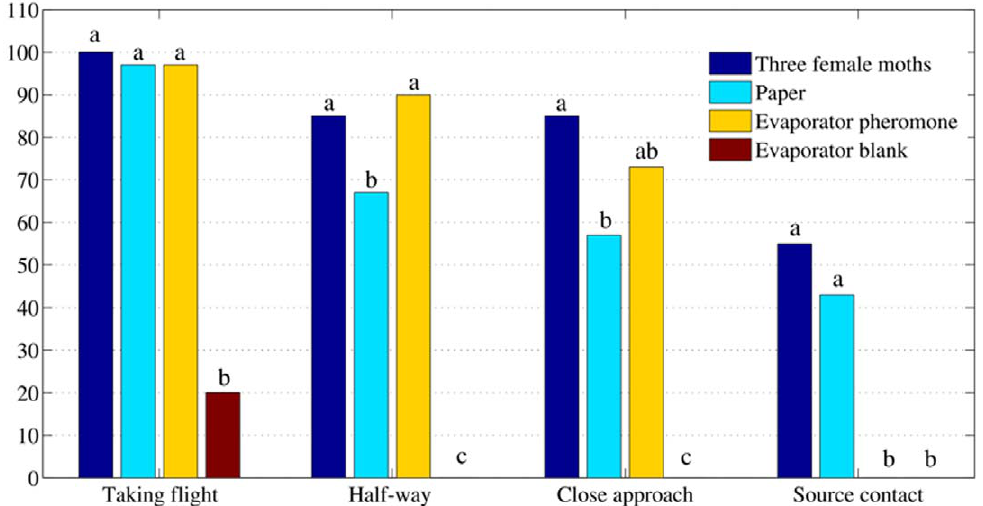
Figure 4. Behavioral responses of S.littoralis males (N=20 for each assay) to a 10 ng/ m l aq. solution of the pheromone containing 4% DMSO released by the evaporator (evaporator pheromone); 3 virgin females; a filter paper containing 10 m g of the pheromone in hexane and to the blank. Same letters over bars corresponding to the same behavior are not significantly different ( x 2 test, P , 0.05).